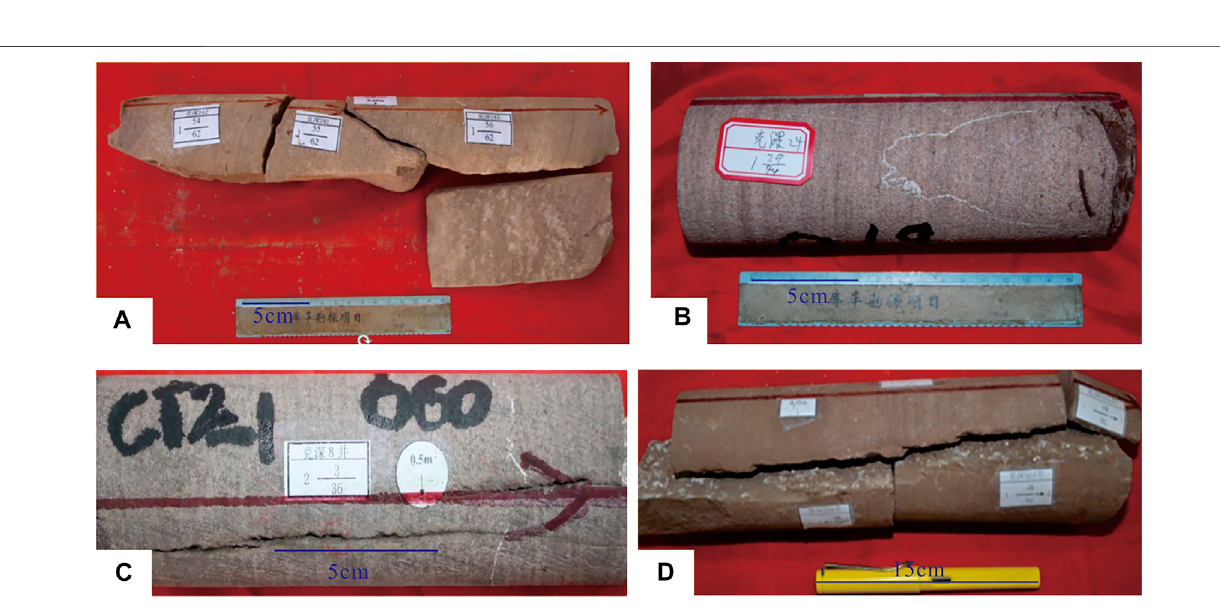
Frontiers in Earth Science |